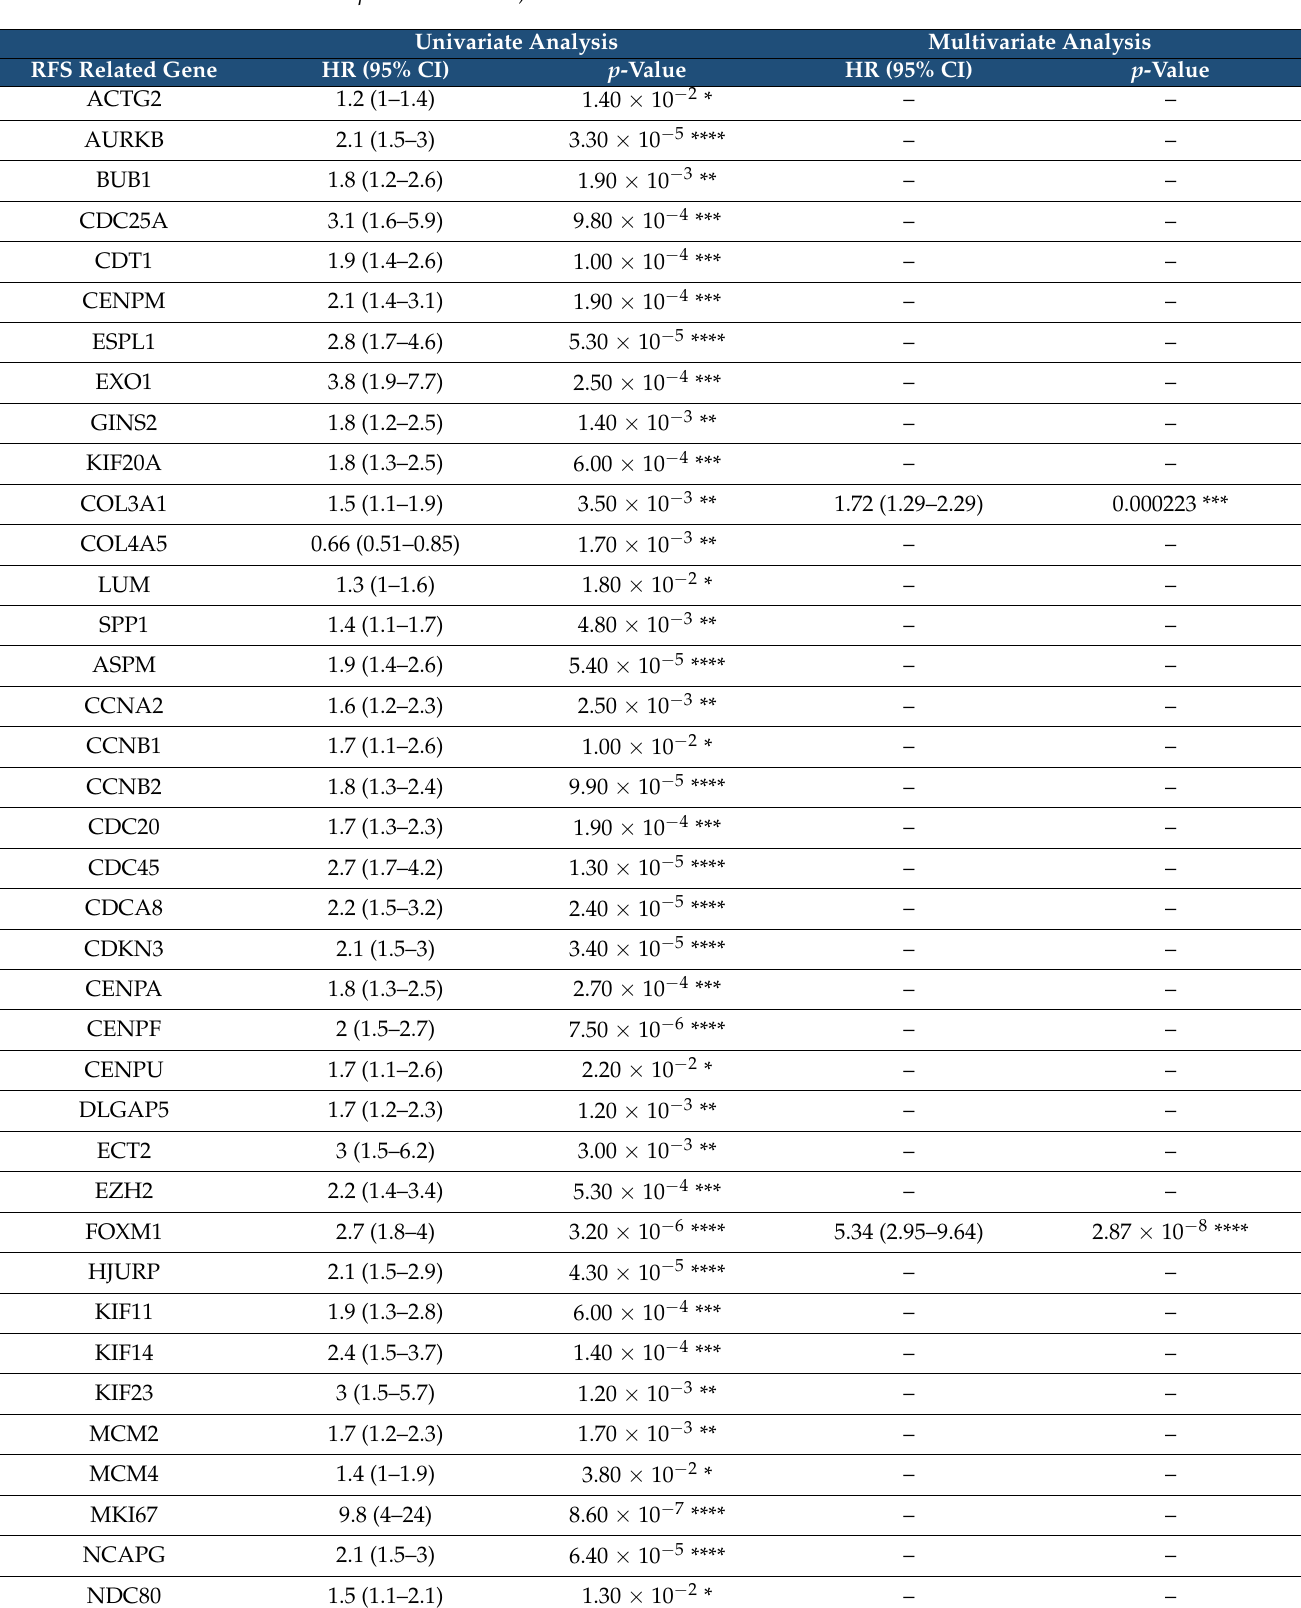
Table 5. Univariate Cox regression analysis of the survival-associated hub genes in BCa patients (HR: hazard ratio, CI: confidence interval, * p -value < 0.05, ** p -value < 0.01, *** p -value < 0.001, **** p -value <